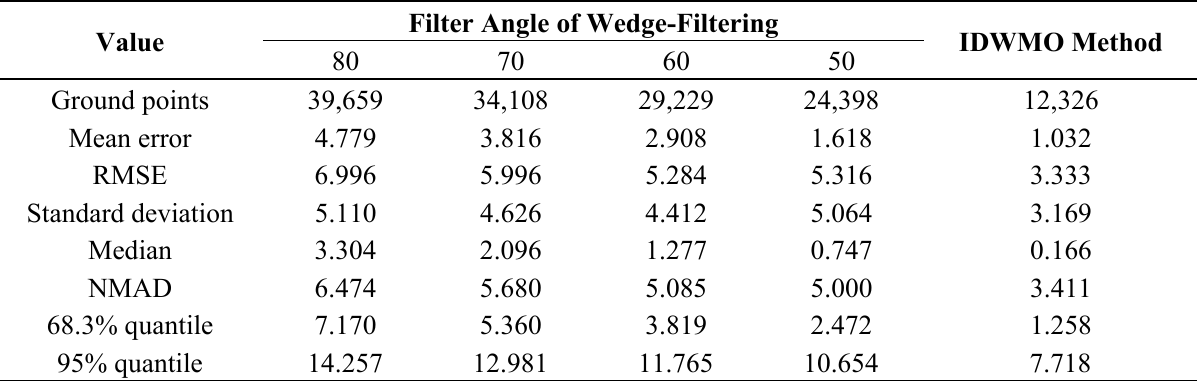
Table 1. Statistical values for the first test